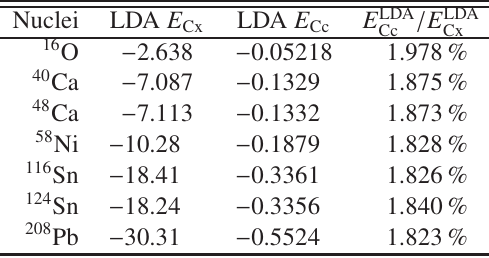
Table 1. Coulomb correlation energies E Cc for selected nuclei. Energies are shown in MeV. Data are taken from Ref.